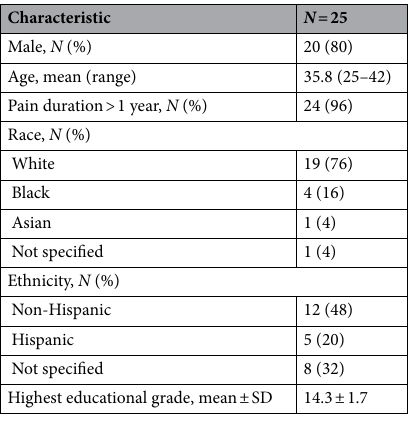
Table 2. Demographics of patients included in the study.